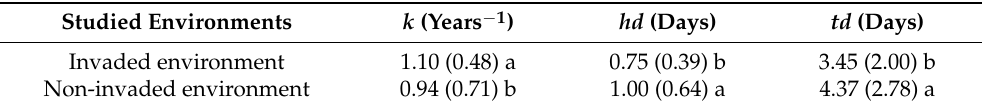
Table 4. Litter decay rate ( k ), half decay time ( hd ), and total decay time ( td ) in both invaded and non-invaded environments in a tropical Cambisol, Caatinga ecoregion, Paraiba, Brazil. Studied Environments k (Years − 1 ) Invaded